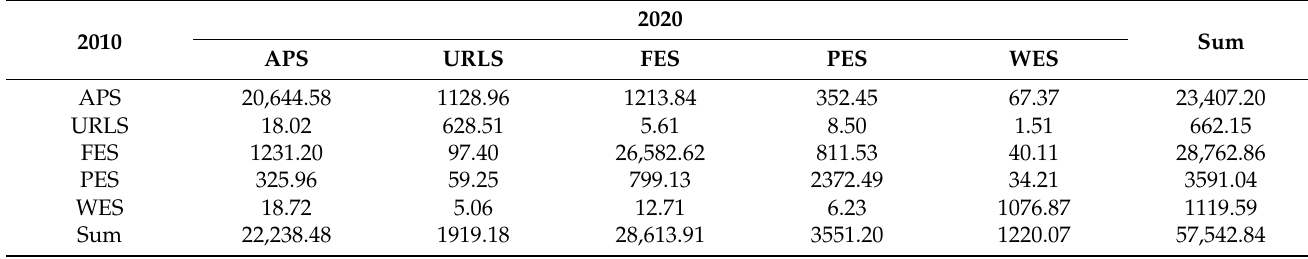
Table 4. Spatial transition matrix of the PLES in the TGRR from 2010 to 2020 (km 2 ).